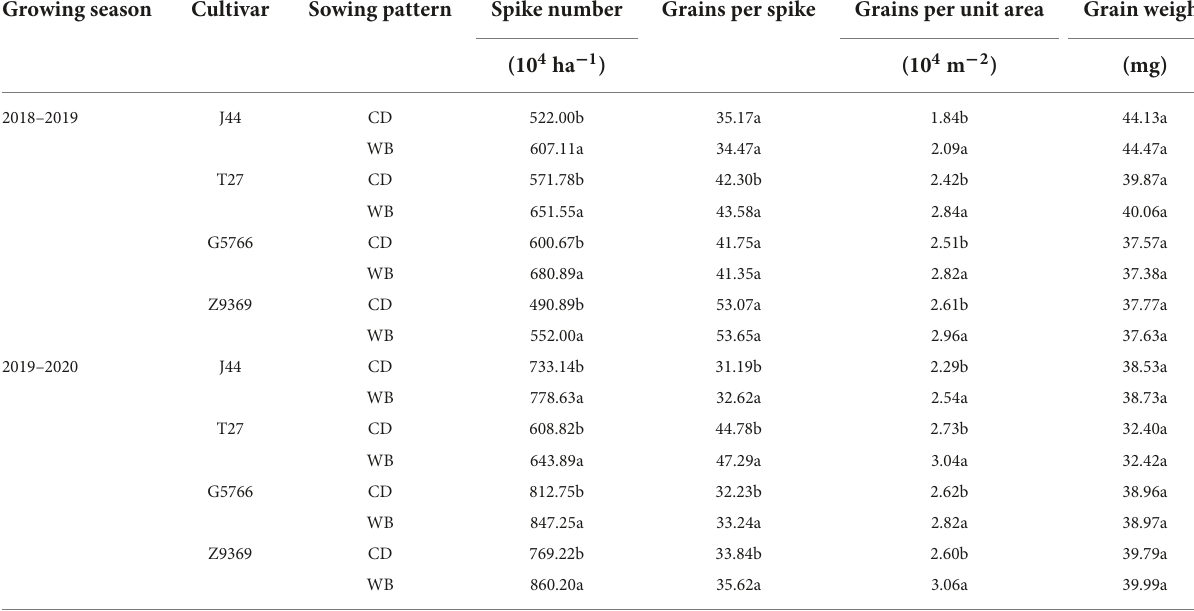
TABLE 2 Effects of sowing pattern on grain yield and components of bread wheat. Growing season